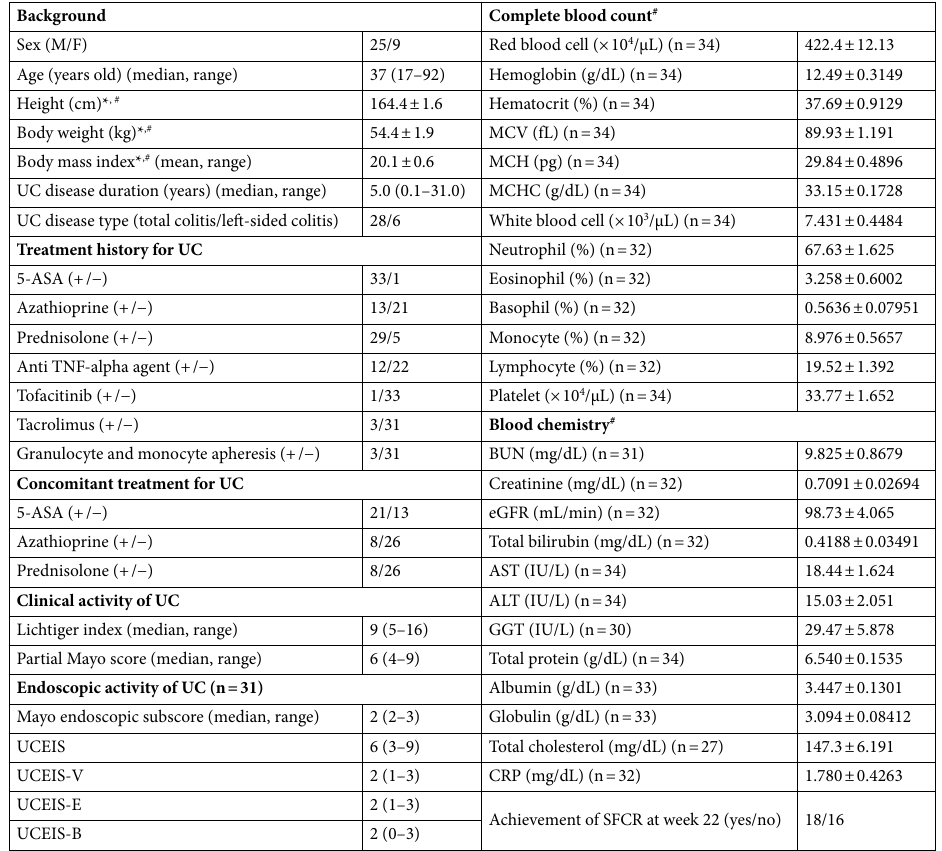
Table 2. Clinical demographics of Cohort 1 (34 patients). *Height, body weight, and body mass index were not measured in one subject. # Height, body weight, body mass index and the results of blood tests are described as the mean ±